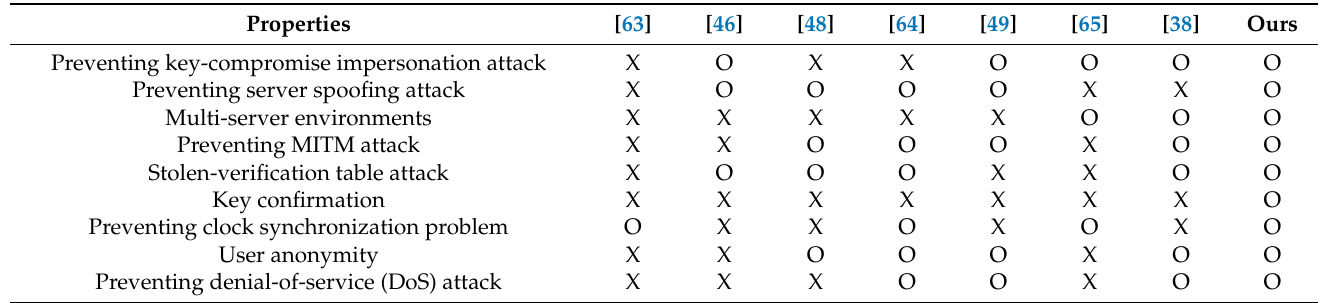
Table 3. Comparisons of Security